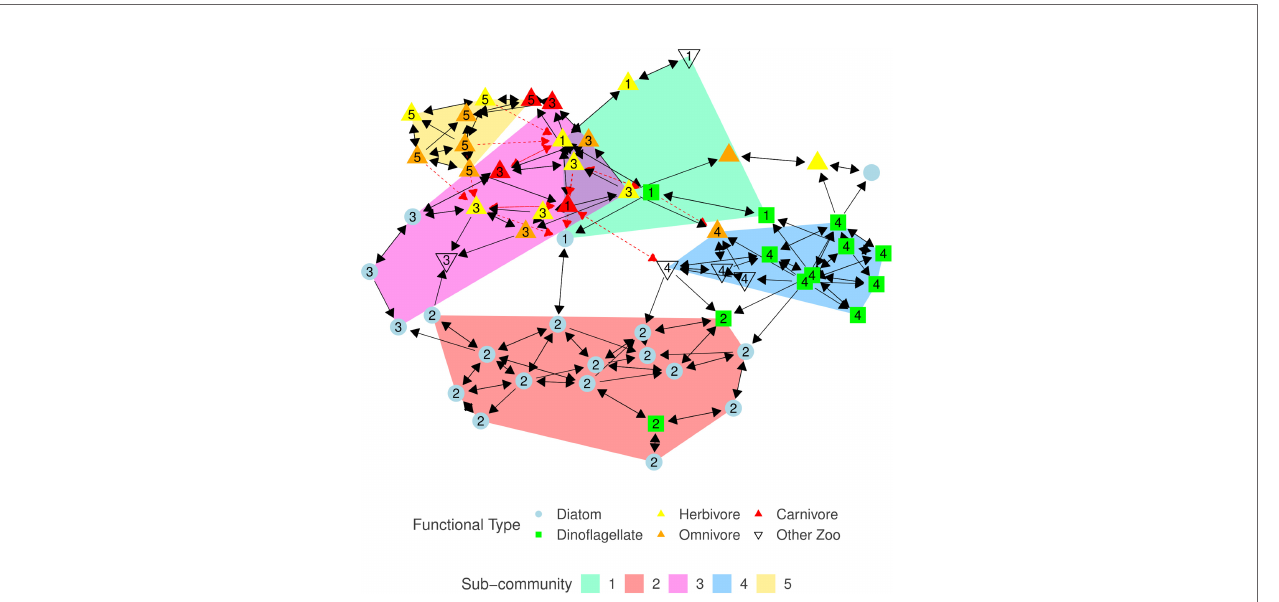
FIGURE 2 | Plankton association graph, G =( V , E ) , constructed from the CPR data using SPRING. Blue circles represent diatoms, green squares are dino fl agellates, up triangles represent zooplankton with the color indicating the copepods diet - yellow, orange, red correspond to herbivore, omnivore, and carnivore respectively, and uncolored down triangles represent other zooplankton classi fi cations. Black solid arrows indicate a positive effect, red dashed arrows indicate a negative effect. Arrow direction from taxon x to y indicates that taxon y responds to the presence of taxon x . Vertex layout is determined using the Reingold-Fruchtermann force- directed algorithm (Fruchterman and Reingold, 1991). Shaded regions, and numeric labels (corresponding to the equivalent sub-graph index, G i ), indicate sub- community membership (if any), for sub-communities containing at least fi ve members; as calculated using the walk-trap algorithm.